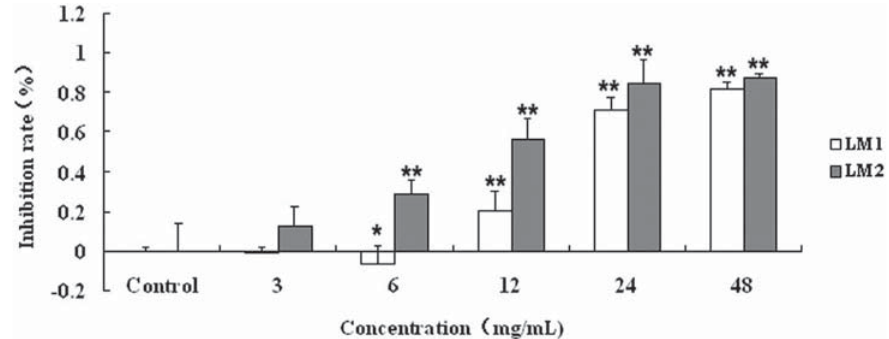
Figure 1- Effect of LM1 and LM2 on viability of CAL-27 cells. Cells were cultured in DMEM+10% FBS with different concentrations of LM1 and LM2 for 72 h. Inhibition rates were determined as described in Material and Methods. Each point is mean ± Standard Deviation of three experiments.*p<0.01 compared to control (0 mg/mL)